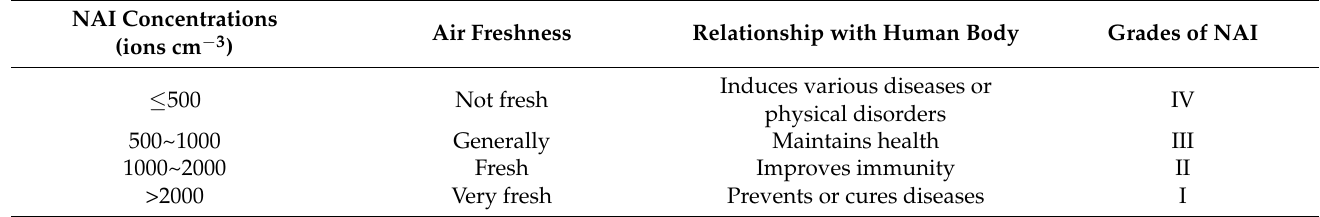
Table 2. The relationship between NAI concentration level standards and human